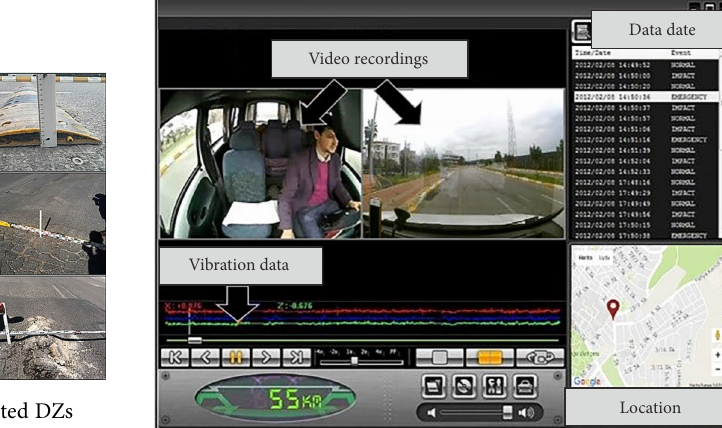
Figure 3. Obtaining of speed and location data by using